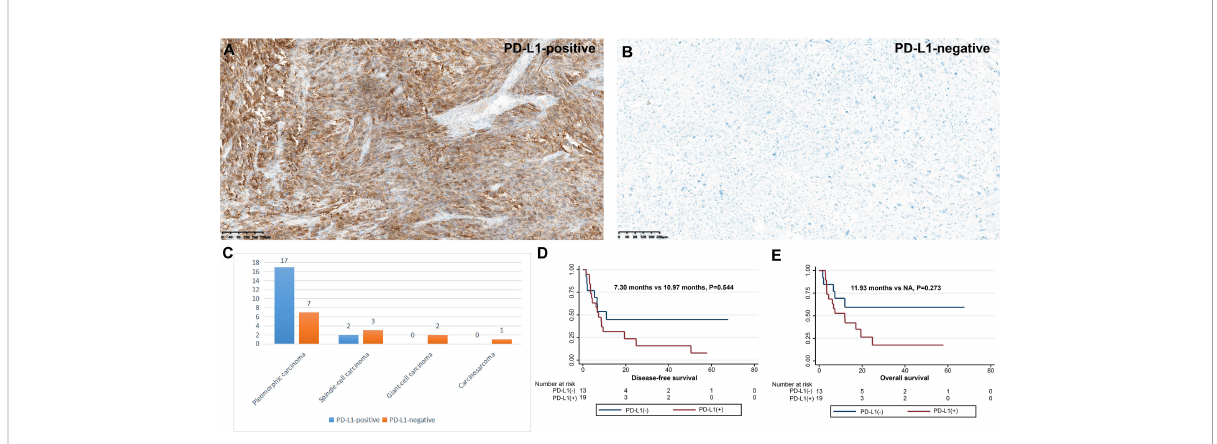
FIGURE 4 Expression and clinical outcome of PD-L1 in PSC. Criteria for positive (A) and negative (B) PD-L1 expression; (C) In fi ltration density of PD-L1 expression in four subtypes of PSC. DFS (D) and OS (E) of different PD-L1 expression